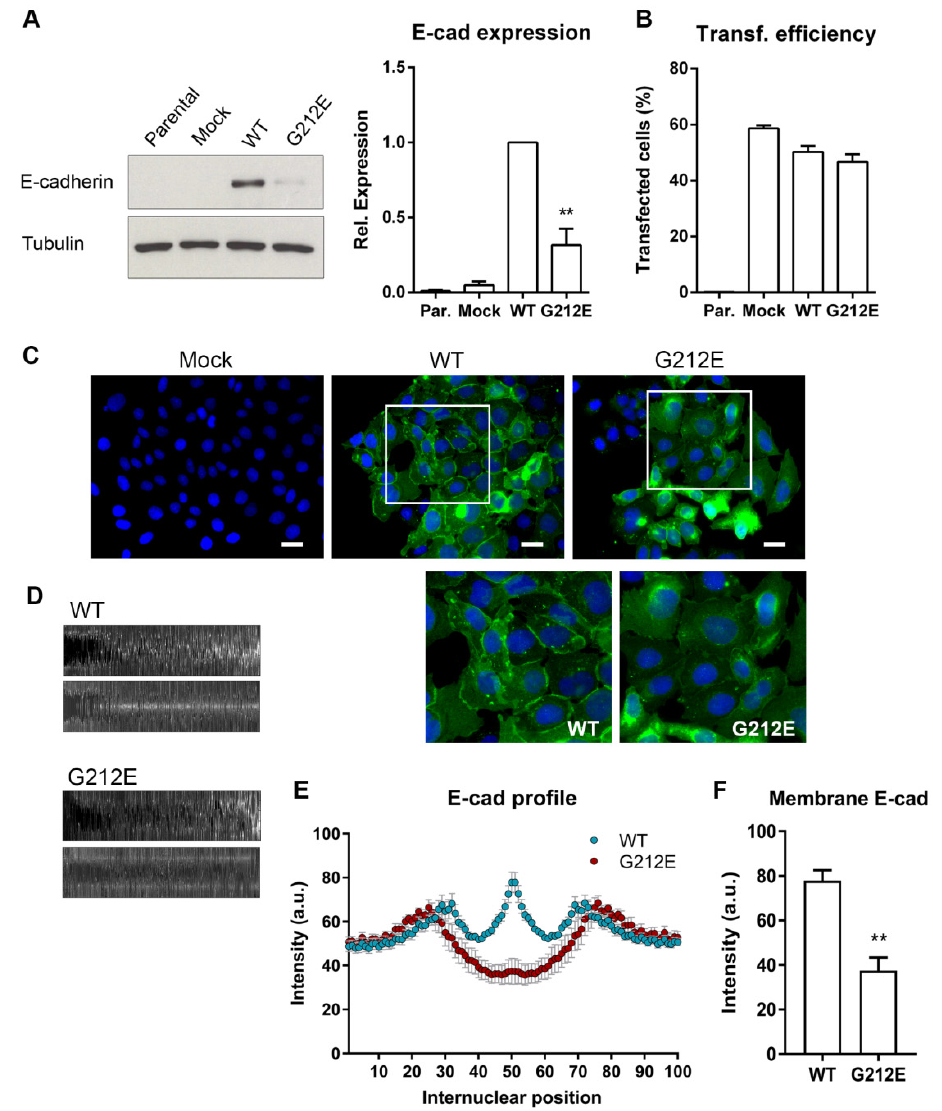
Figure 3. Expression profile of the E-cadherin missense variant G212E. ( A ) E-cadherin protein expression was analyzed by Western Blot in CHO cells transfected with wild-type E-cadherin, the variant G212E, and the empty vector (Mock). α -Tubulin was used as loading control. The intensity of the bands was quantified and normalized against wild-type E-cadherin cells. In the graph, bars represent average + SE of E-cadherin protein levels in four independent experiments. ( B ) Transfection efficiency was evaluated by flow cytometry using GFP levels. ( C ) Immunofluorescence showing E-cadherin localization (green staining) of wild-type, G212E, and Mock cells. Nuclei were counterstained with DAPI (blue). Scale bars represent 20 μ m. Enlarged image showing the diffuse pattern of G212E E-cadherin, when compared with that of the wild-type protein at the plasma membrane. ( D ) Internuclear profiles encompassing signal intensities along contiguous cells were extracted (upper map) and geometrically compensated (bottom map). ( E ) Quantification of mutant and wild-type E-cadherin expression profiles. ( F ) Graph displays mean + SE of fluorescence intensity at the internuclear position 50, which corresponds to the plasma membrane. ** represents p ≤ 0.01.